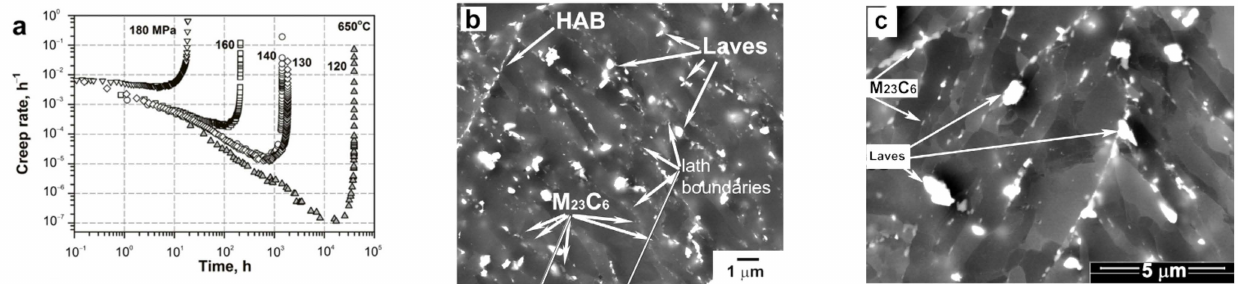
Figure 16. Creep rate vs. time curves of the 10Cr steel at 650 ◦ C and different applied stresses from 120 to 180 MPa ( a ). The lath structure and dispersion of particles in the 10 Cr steel at the apparent steady-state creep stage at 650 ◦ C and 120 MPa, 10,000 h on the high-angle boundary (HAB) and lath boundaries ( b ) Reprinted with permission from Ref. [8], Copyright Elsevier 2019; after creep rupture test for 39,437 h ( c ). Reprinted with permission from Ref. [15], Copyright Elsevier